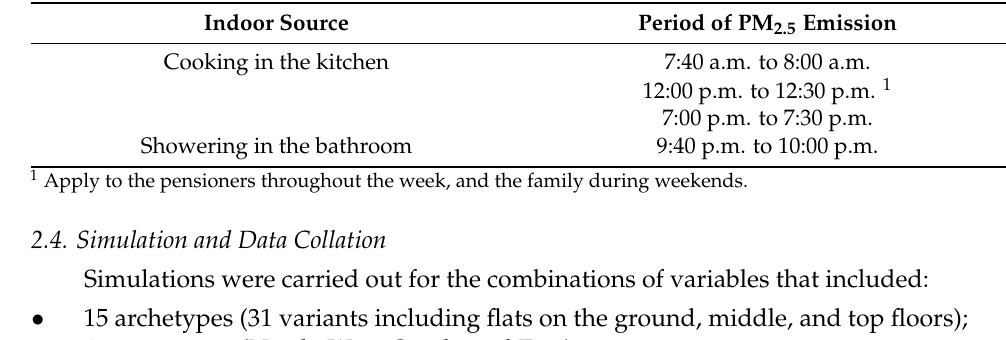
Table 4. The periods of PM 2.5 emissions from indoor